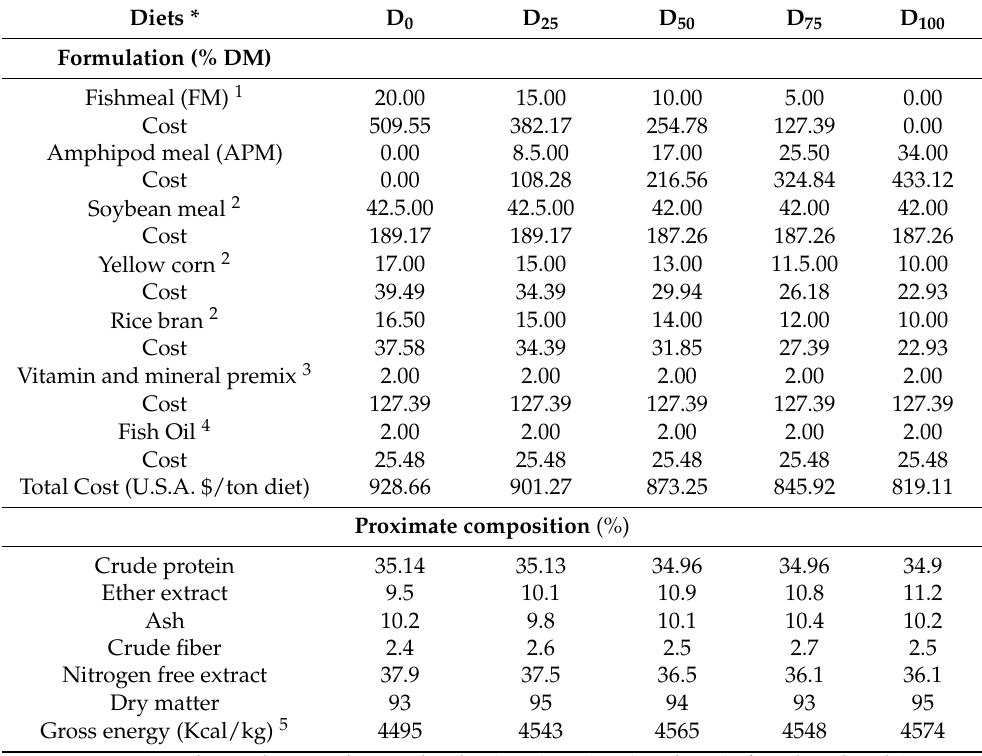
Table 3. Formulation (% DM), cost (U.S.A. $/ton diet − 1 ), and proximate composition (%) of the experimented